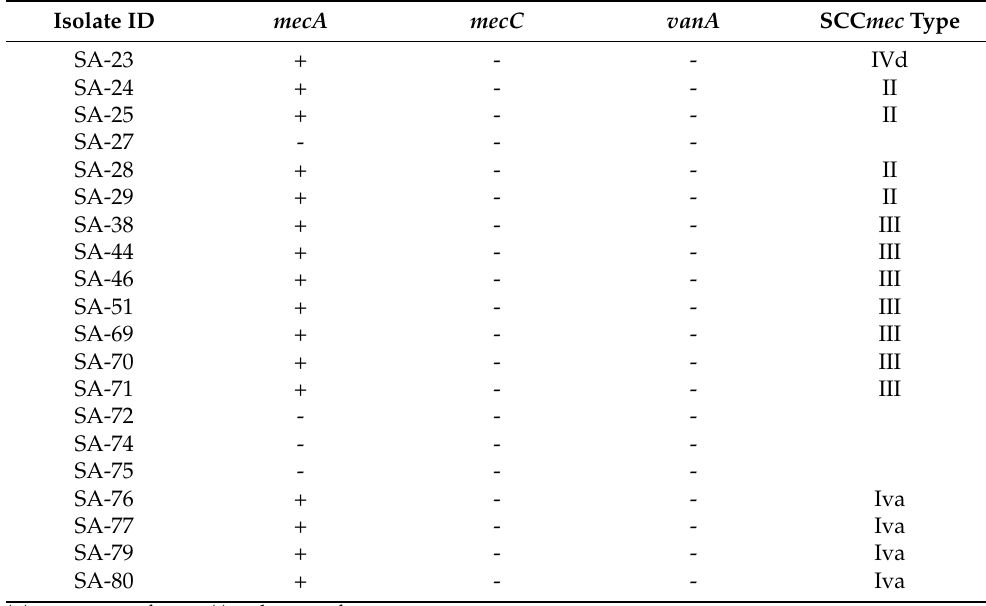
Table 3. PCR based screening of antimicrobial resistance genes in MRSA isolates. Isolate ID